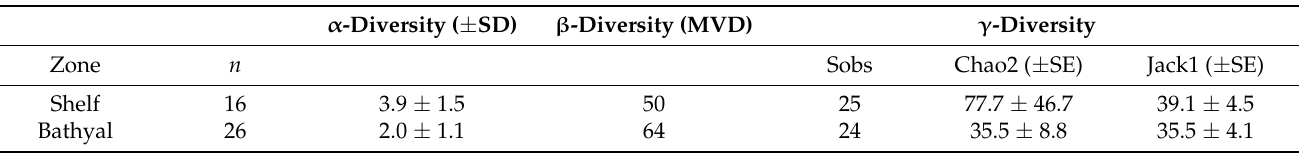
Table 4. Spatial-temporal differences in α -diversity and species composition based on Sørensen dissimilarities detected with a two-factor linear model, using ANOVA (A) and PERMANOVA (B), respectively. In both, the probability of pseudo-F was estimated using 9999 permutations of residuals under the reduced model. The square roots of the variance components (